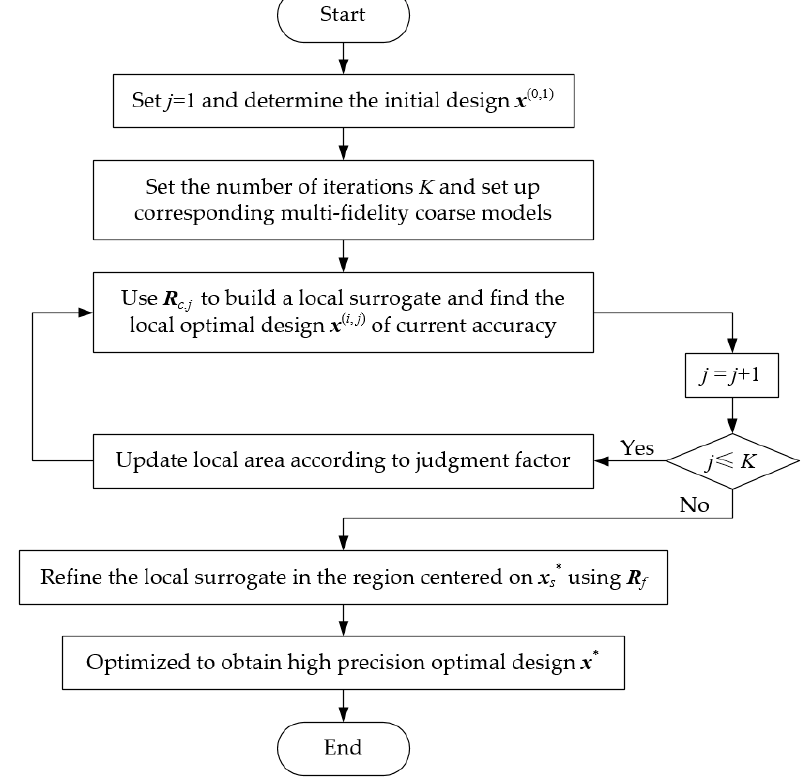
Figure 2. Complete flowchart of the proposed algorithm.